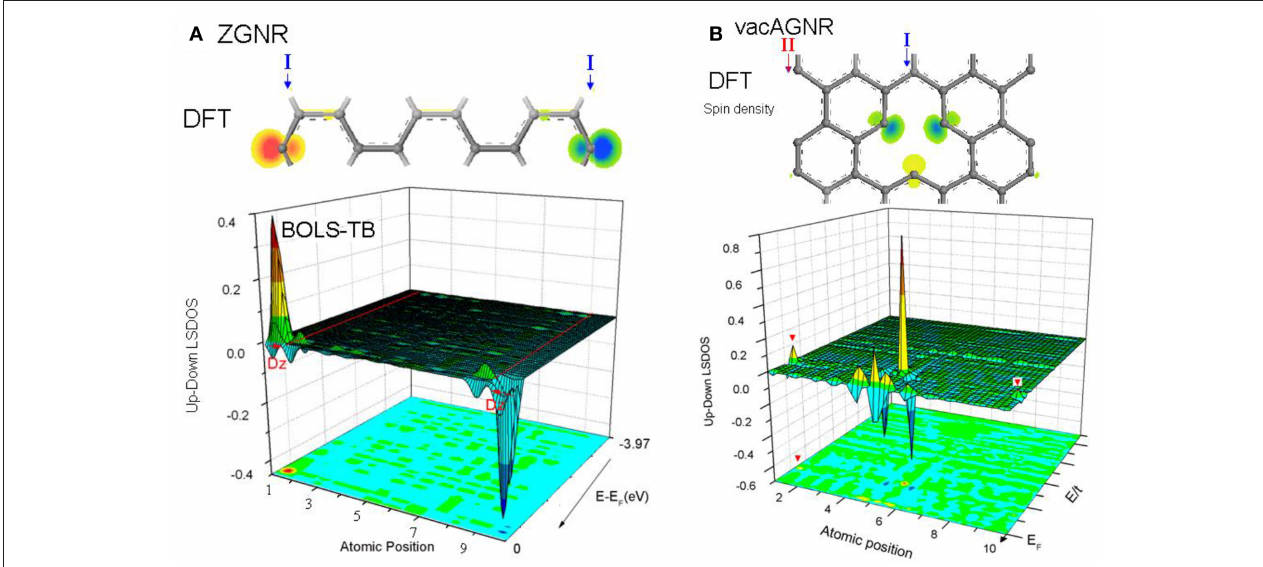
FIGURE 9 | DFT-derived spin electron density and BOLS-HM derived difference LSDOS for (A) ZGNR and (B) H-ZGNR. Zigzag edge manifest a strong local magnetism caused by both D z and trapped edge p z electron. Hydrogenation annihilates D z but leaves a weak magnetism. Reprinted with permission from Zhang et al. [ 90].